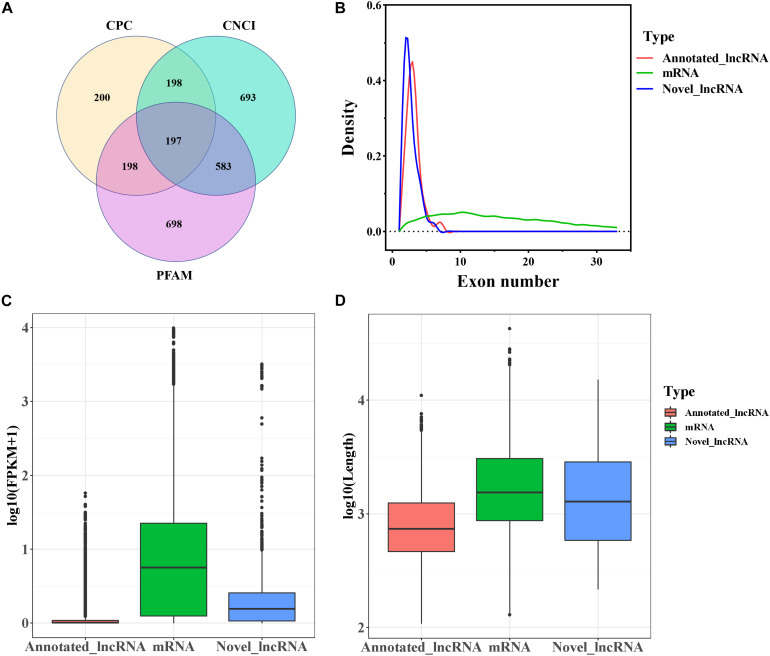
Genomic characteristics of mRNAs and lncRNAs in goat follicles. (A) Screening of candidate lncRNAs by CPC, CNCI, and PFAM. (B) The density curve of exon numbers. (C) Boxplot of the expression level of mRNAs and lncRNAs [expressed as log10 (FPKM+1)]. (D) Boxplot of sequence length [expressed as log10 (length)].